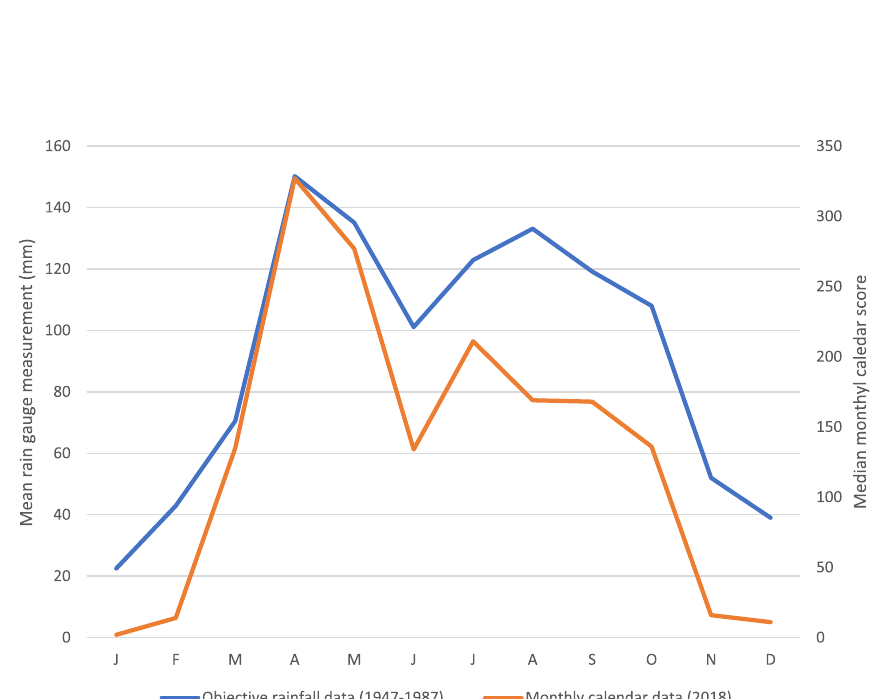
Fig. 5 Objective rainfall data and monthly calendar rainfall pattern,